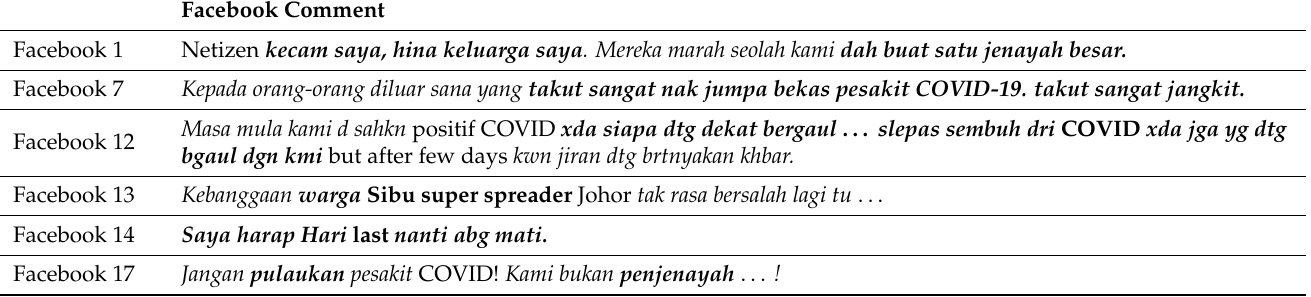
Table A1. Examples of stigmatization of COVID-19 patients in Facebook comments on health (N = 20).